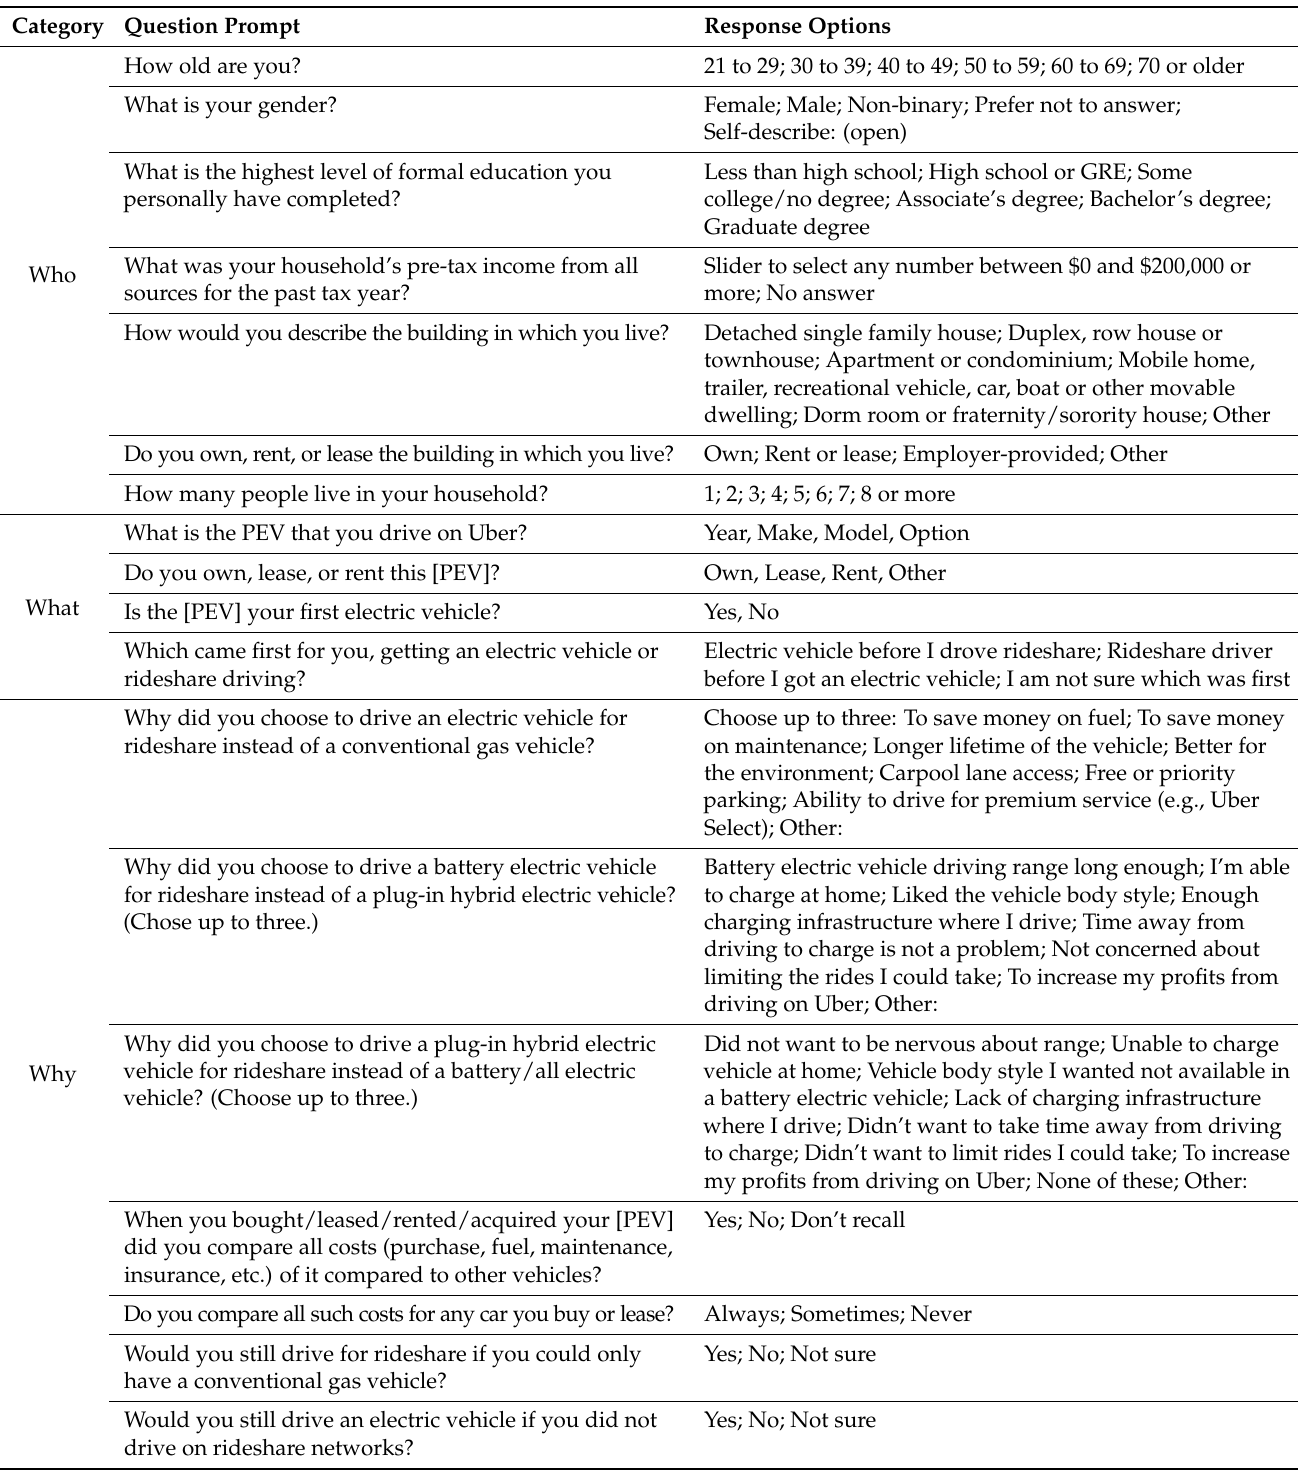
Table 1. TNC-PEV Driver Survey